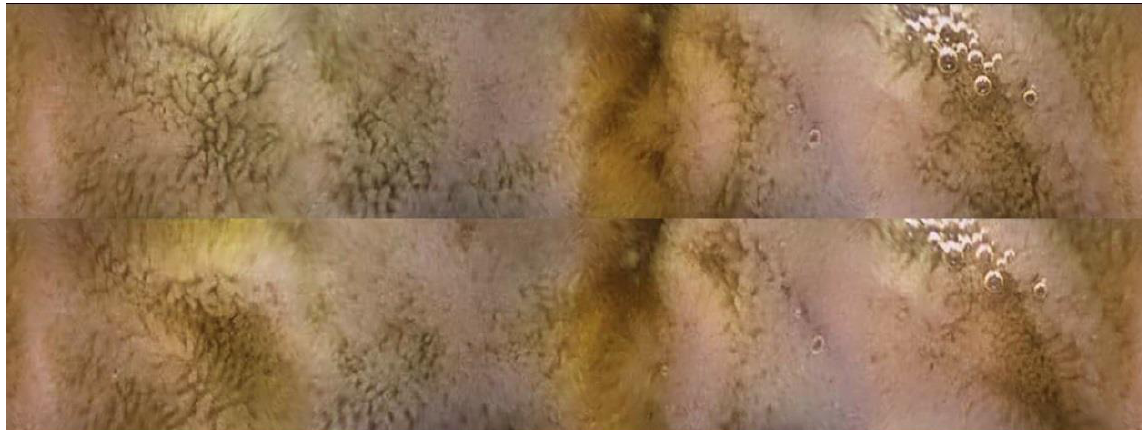
Pharmaceuticals 2021 , 14 , 590 Figure 5. Wireless capsule enteroscopy. Normal jejunum. Figure 5. Wireless capsule enteroscopy. Normal jejunum.